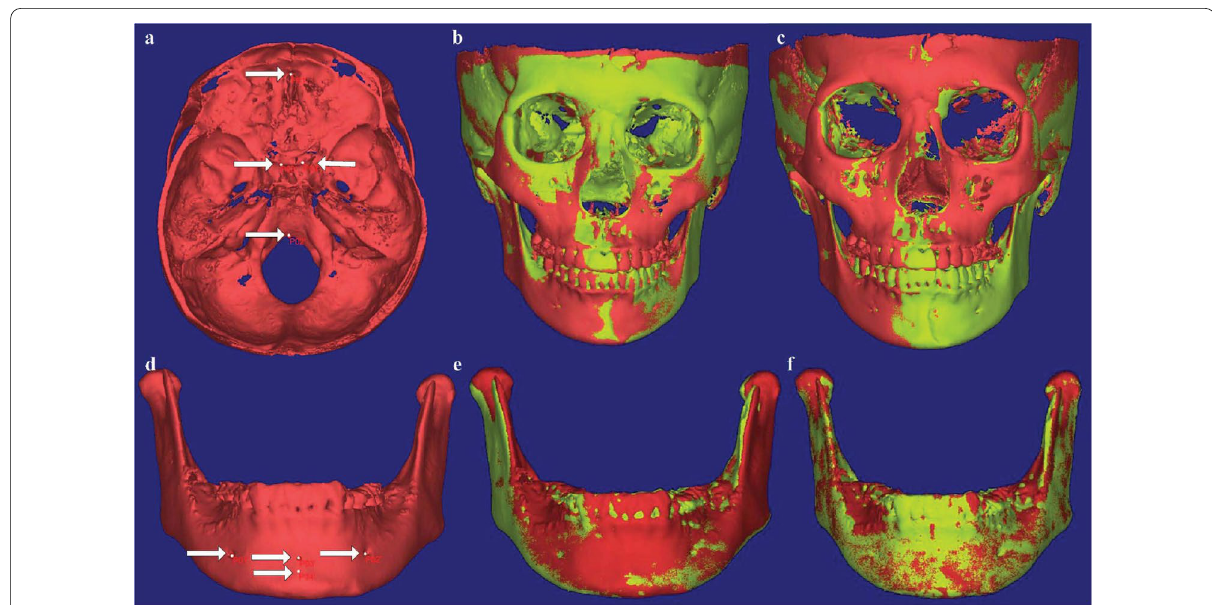
Fig.3 The deviated side of the mandible is on the patient’s own left side. a , d landmark points of cranial base and mandibular superimpositions, respectively; b , e frontal view of point registration; c , f frontal view of STL registration